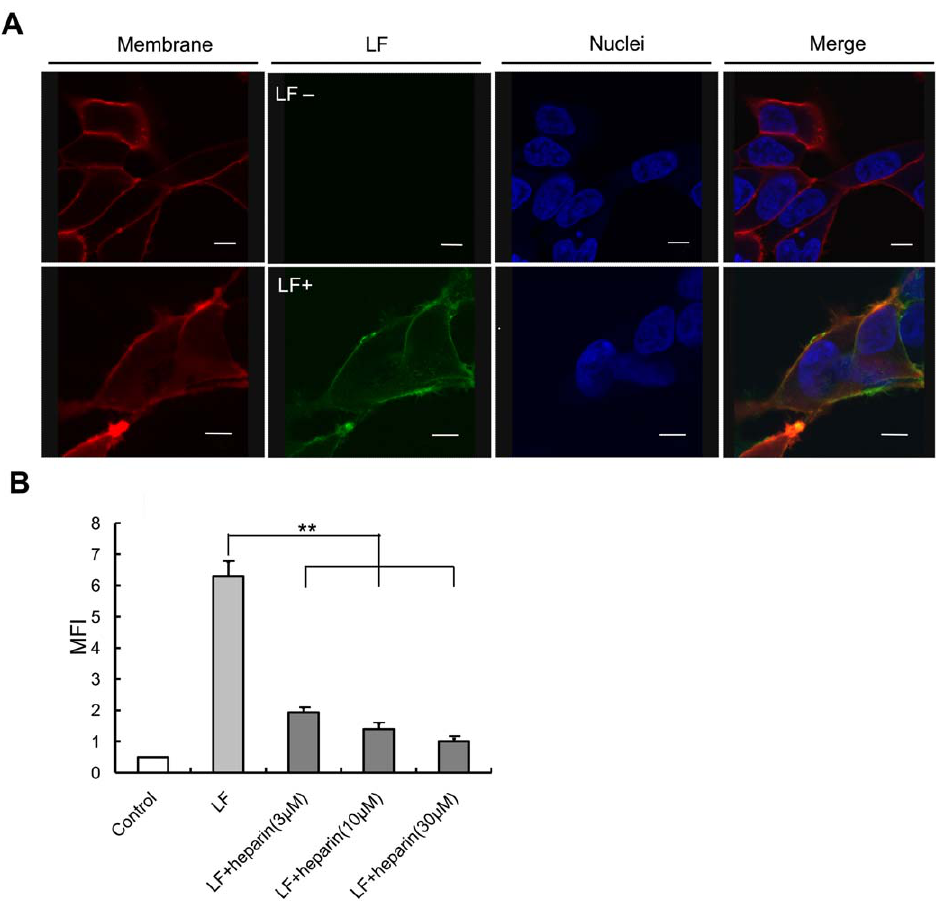
Figure 3. Lactoferrin localizes to the cell membrane by targeting HSPGs. ( A ) LF is present on the cell surface. Oregon Green-labeled LF localization was observed under confocal microscopy. LF untreated cells were used as control. Cell membrane and nuclei were stained with DiI and Hoechst33342, respectively. Scale bar, 8 m m. ( B ) Heparin inhibits LF binding to HEK293E/ACE2-Myc cells. HEK293E/ACE2-Myc cells were incubated with 0.5 m M Oregon Green-labeled LF at 4 u C for 1 h after pretreatment with heparin at the concentration of 3 m M, 10 m M or 30 m M. The MFI was measured for each group by flow cytometry as described above. Error bars represent the SD of three independent experiments. **P , 0.01.